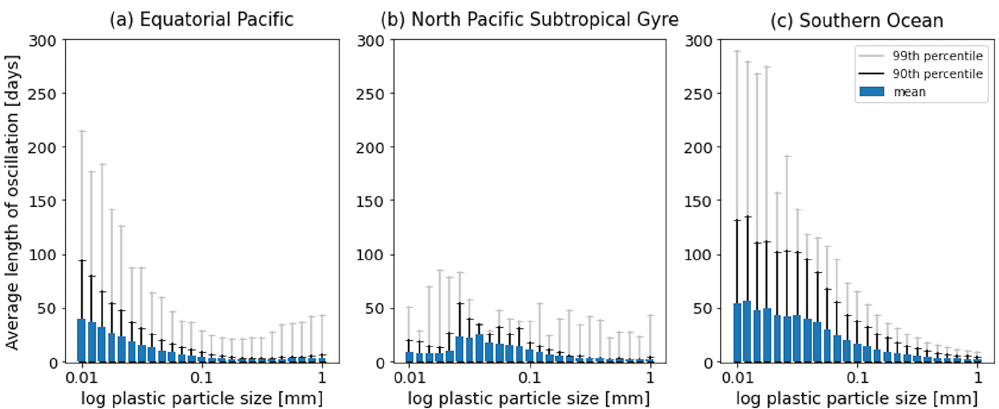
Figure 7. The average length [d] of the oscillations over the 1-year simulations in Fig. 2. Results for the 25 size bins (particles with a radius between 0.01 and 1mm) for the three regions shown: (a) equatorial Pacific, (b) North Pacific Subtropical Gyre and (c) Southern Ocean. The 90th percentile for each size bin is represented by the black line, and the 99th percentile is represented by the grey line.